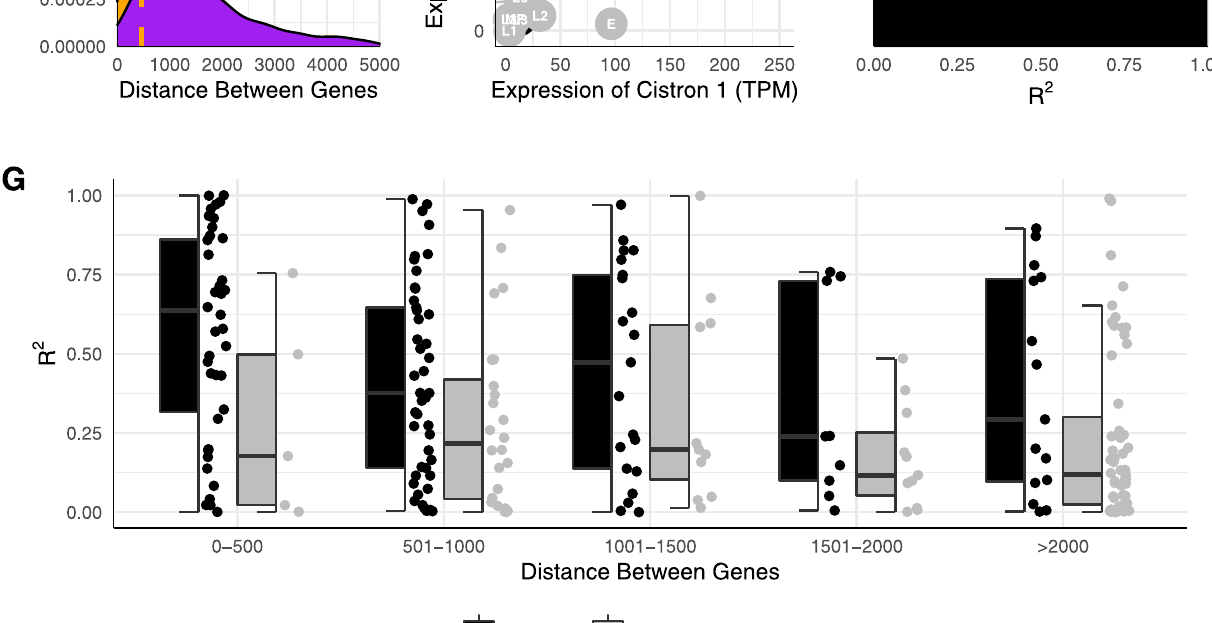
PLOS NeglectedTropical Diseases | https://doi.org/10.1371/journal.pntd.0008869 November16, 2020 12 /